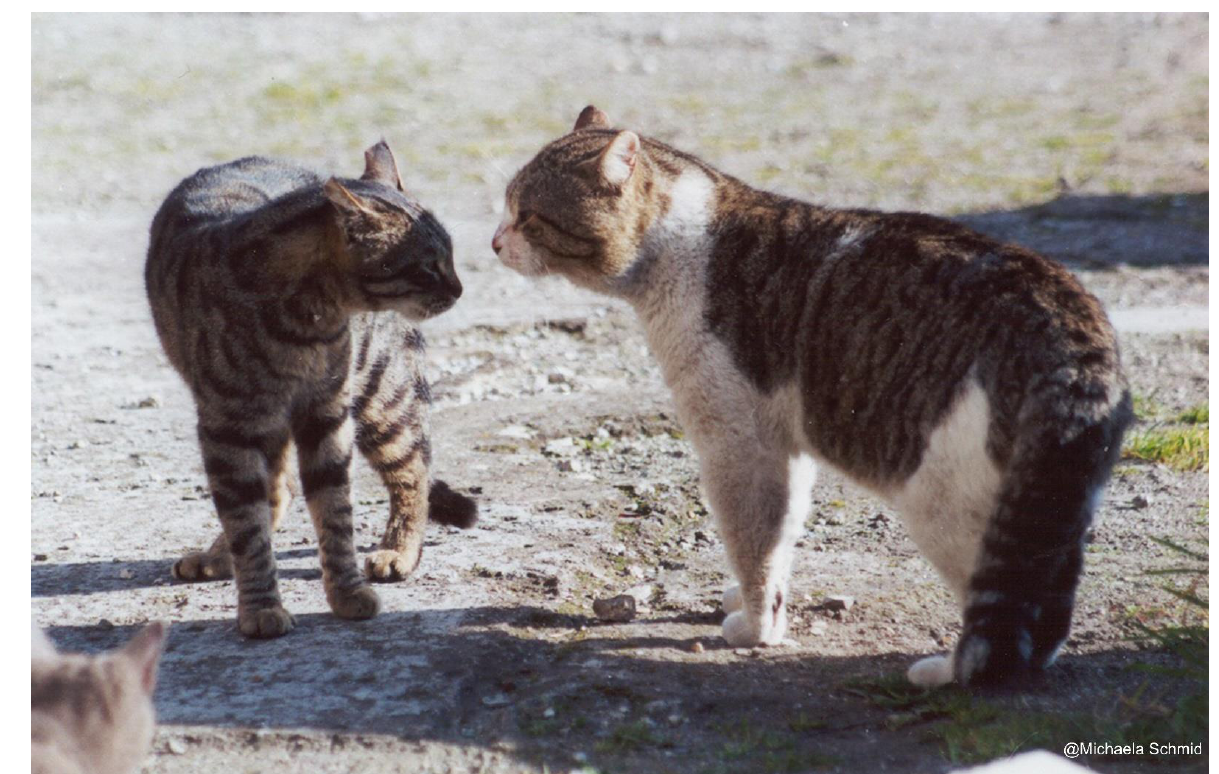
Figure 5. Vocal duel between two males of the same group; the male on the right was the first in the hierarchy, weighed 6 kg, sired 13 kittens, and was positive to feline immunodeficiency virus (FIV); the male on the left was the seventh in the hierarchy, weighed 4 kg, sired 8 kittens, and was FIV negative [45] (credit Michaela Schmid).